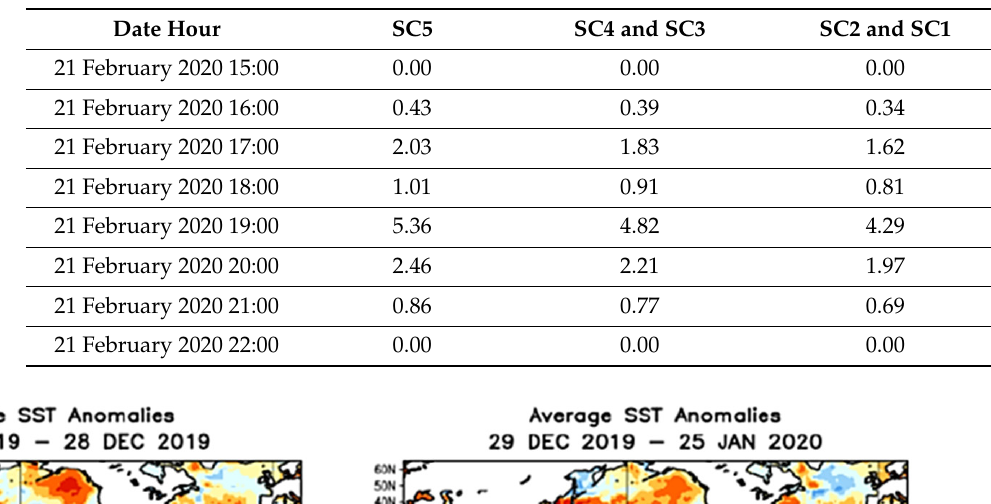
Table 7. The intensity of precipitation over each sub-basin (mm/h).